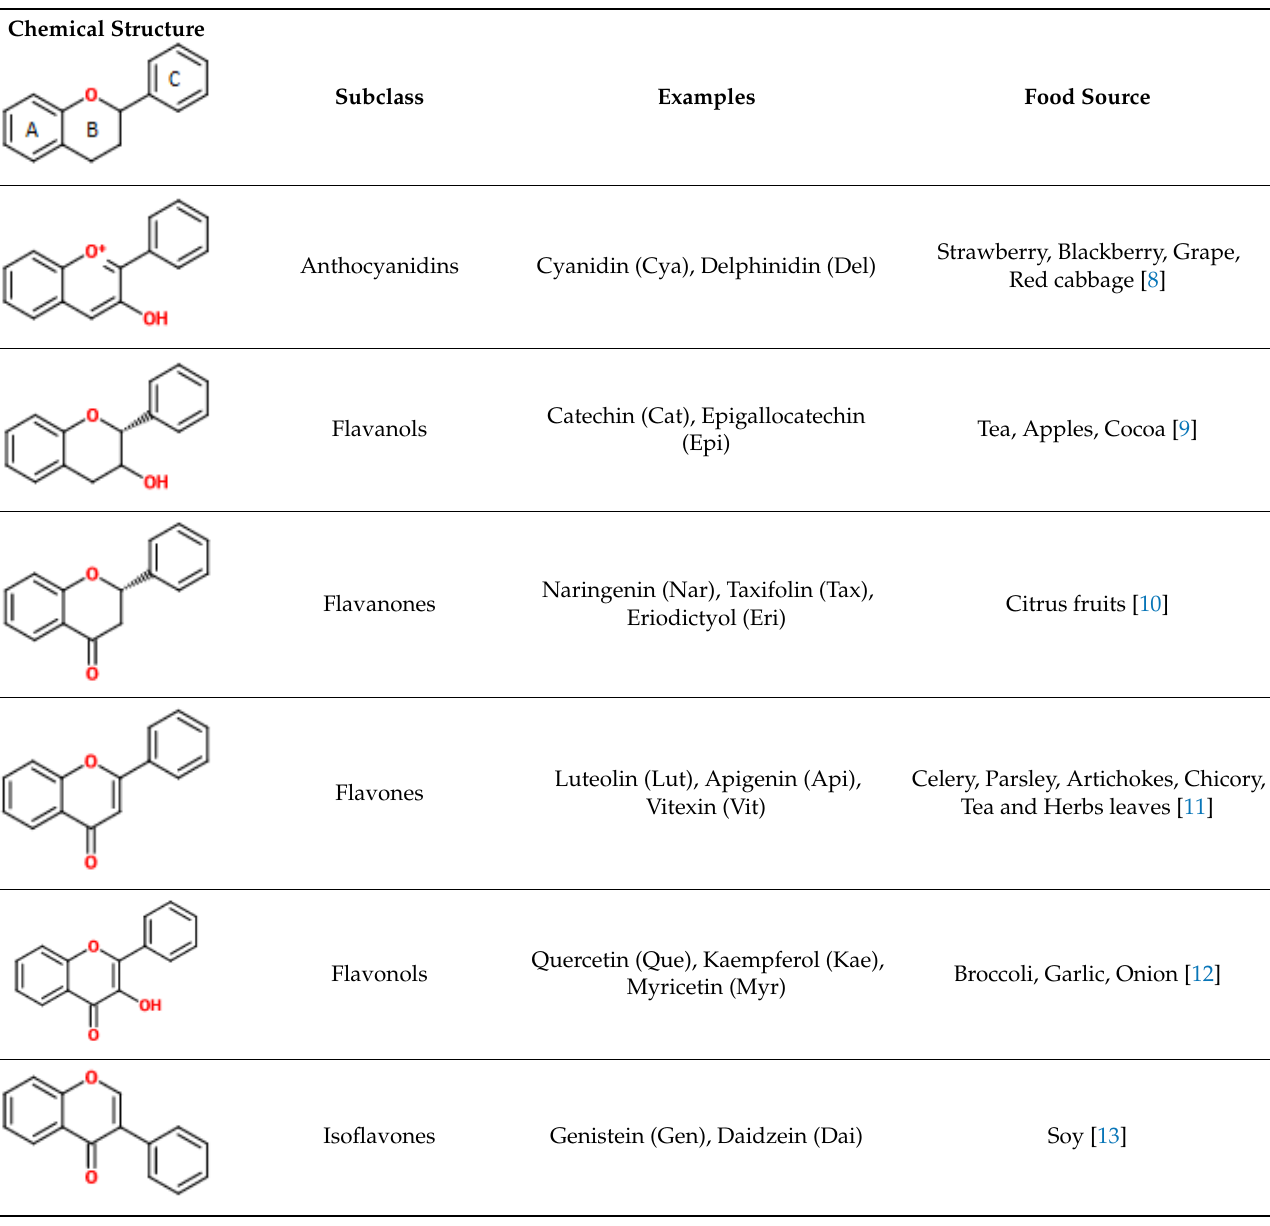
Table 1. Chemical structures, subclasses, and food sources of flavonoids.